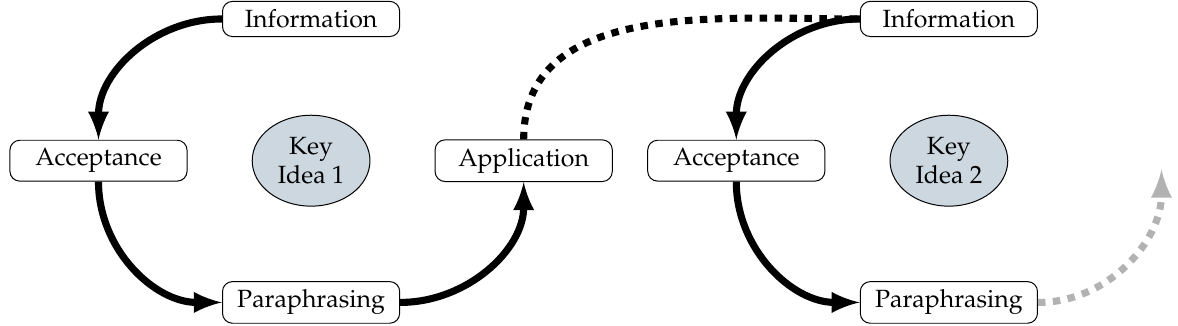
Figure 3. Visualizing the cyclic process of an acceptance survey (own